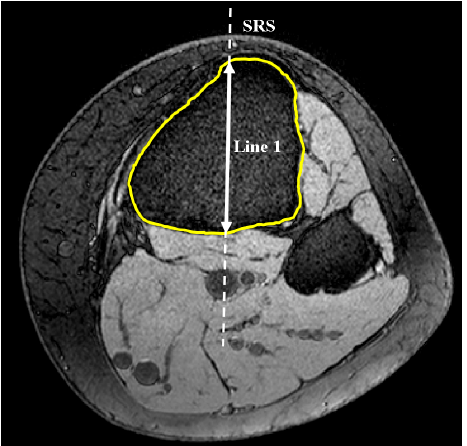
Figure 2. Axial view. Determination of the longest AP line constrained to tibial border in plane 1 and therein defining SRS (axial view).